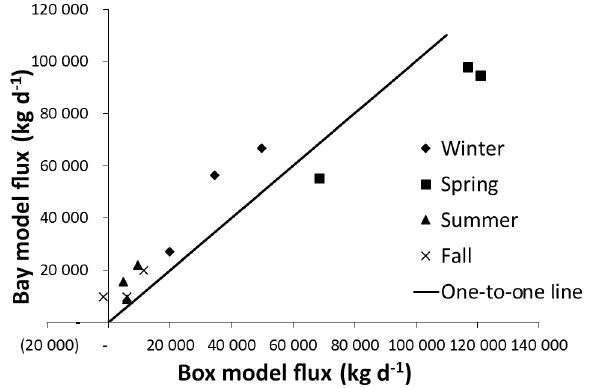
Figure 9. Correlation between the fluxes estimated from the box model used in this study and the Chesapeake Bay nutrient